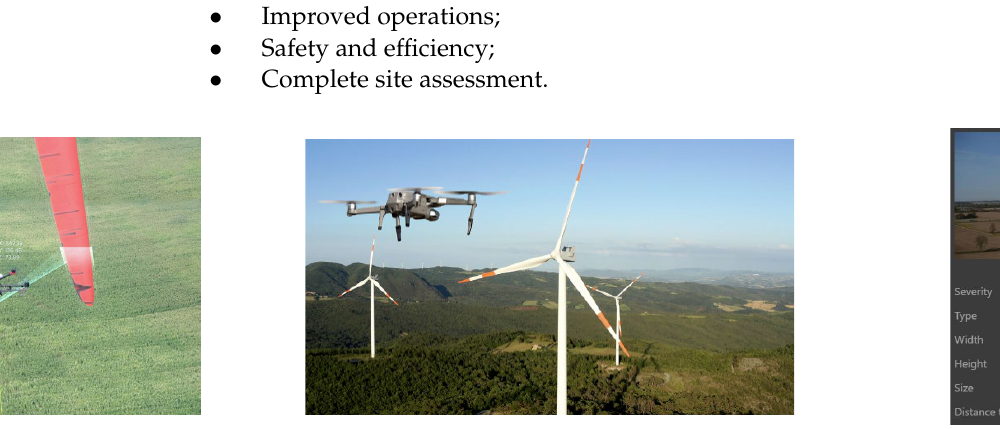
Figure 11. Drone inspection